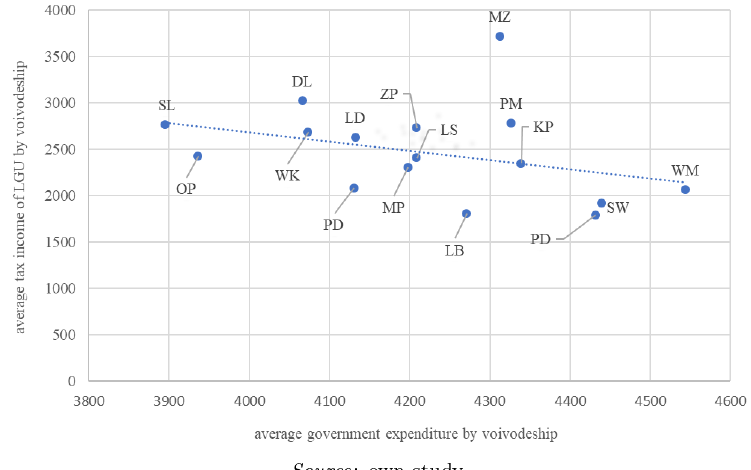
Source: own study. Figure 4: Average government expenditure (in terms of voivodeship) versus average tax revenues of LGU (in terms of voivodeship) in 2010(cid:21)2018 in Poland REGION : Volume 9, Number 1,